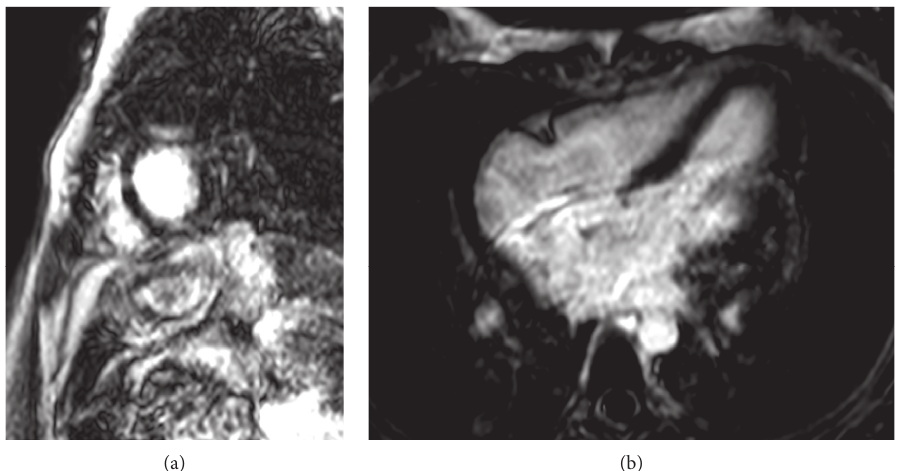
Figure 2: Repeat T1-weighted delayed gadolinium-enhanced magnetic resonance images in (a) short axis and (b) four-chamber views demonstrating the resolution of previously seen delayed contrast